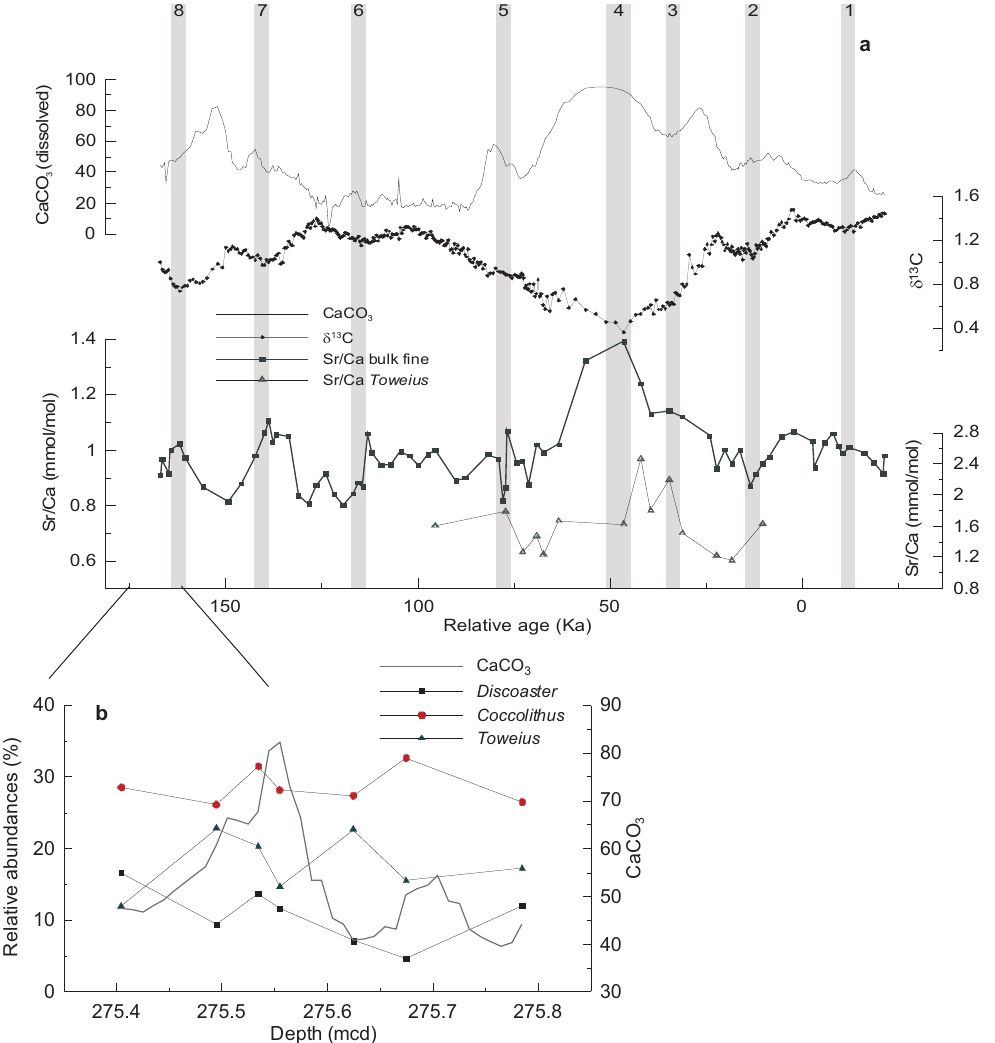
Fig. 6. (a) Long-term Sr/Ca productivity record measured in bulk fine sediments and Sr/Ca measured by ion probe in Toweius , in correlation to the calculated dissolved carbonate (Stap et al., 2009) and bulk δ 13 C (Stap et al., 2009). Grey bars represent precessional cycles as identified by Stap et al. (2009), (b) the changes in assemblage composition across the H2 event.